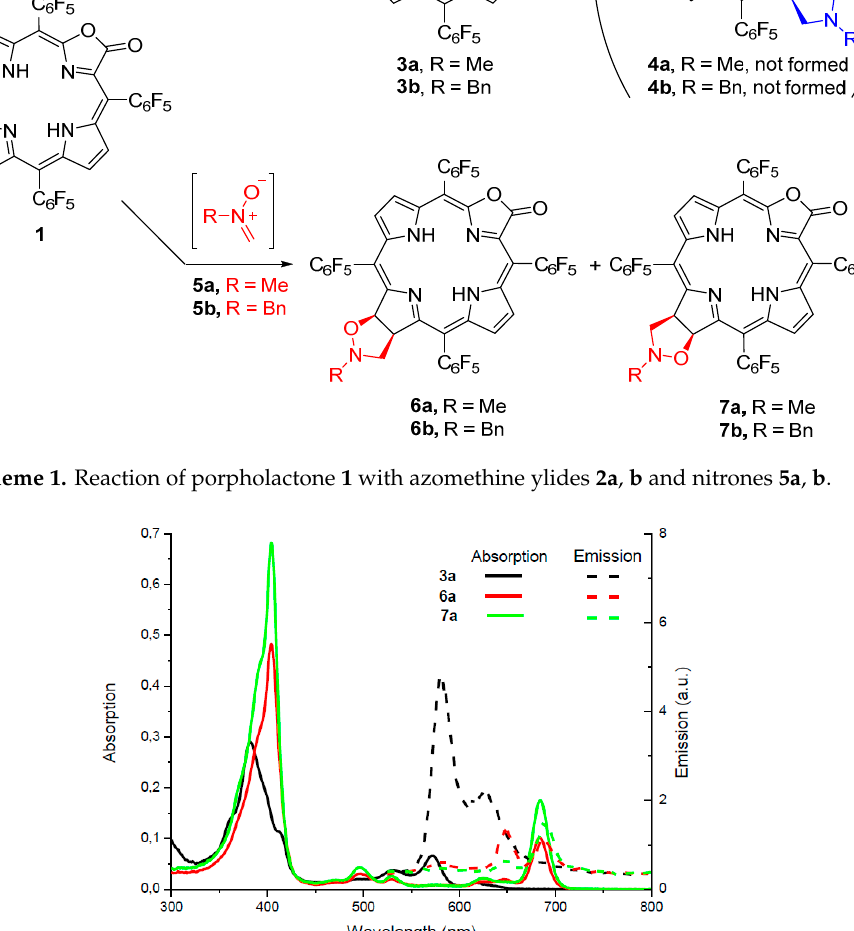
Figure 3. Ball-and-stick representation of the pyrrolidine-fused porpholactone derivative 3b . The chiral centers are indicated by an asterisk. Hydrogen atoms were omitted for clarity reasons.